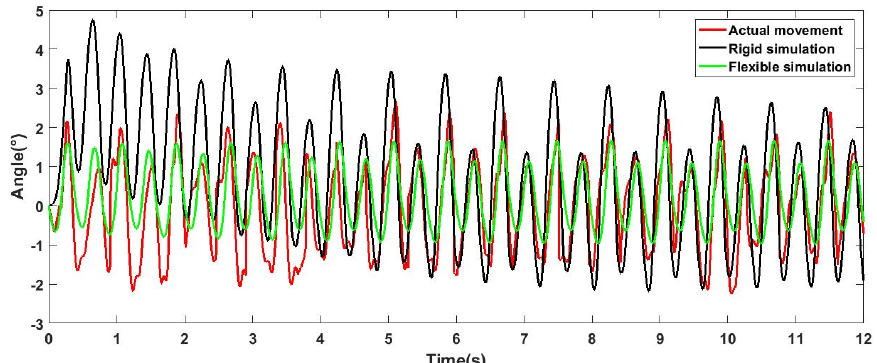
Figure 17. Deviation diagram of robot pitching direction.